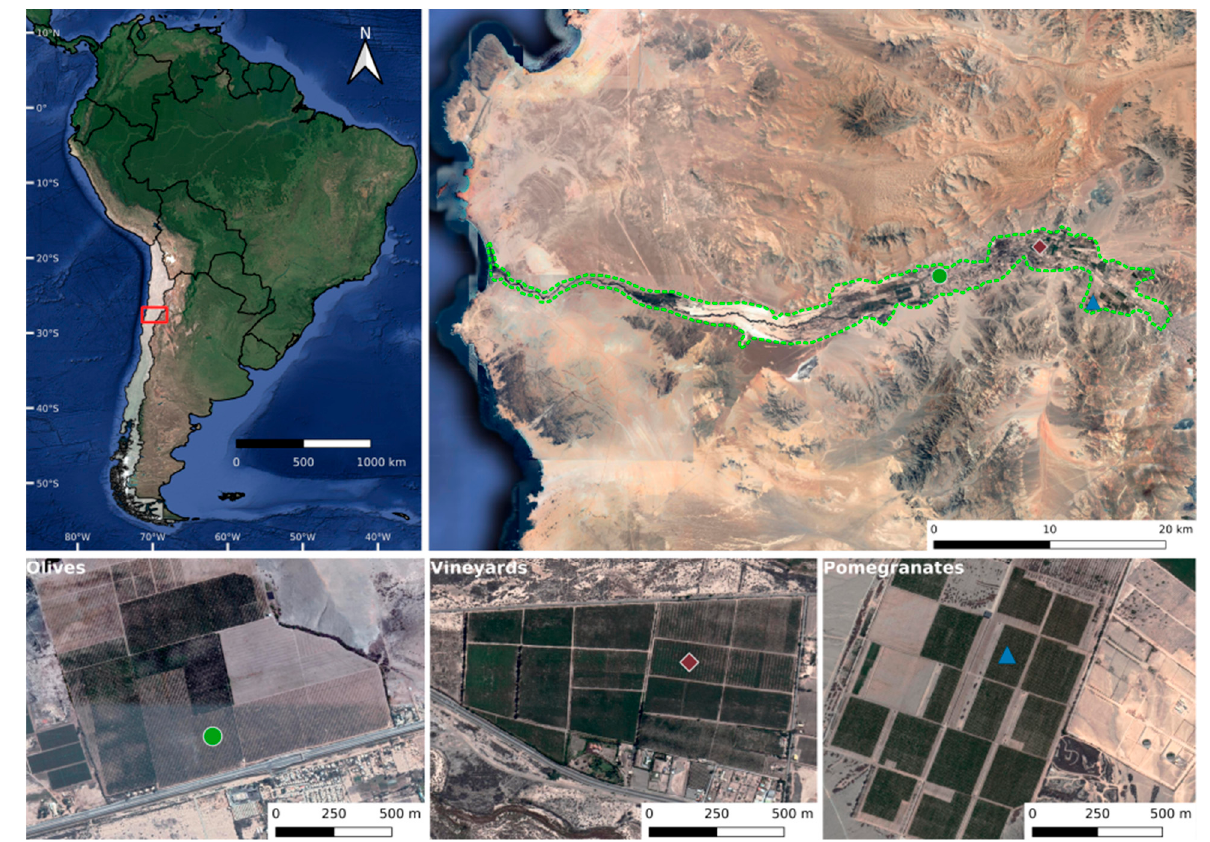
Figure 1. Study area delimited by a green light dashed line (top). Location of three meteorological stations distributed in olives (green circle), vineyards (red diamond), and pomegranates (blue triangle).